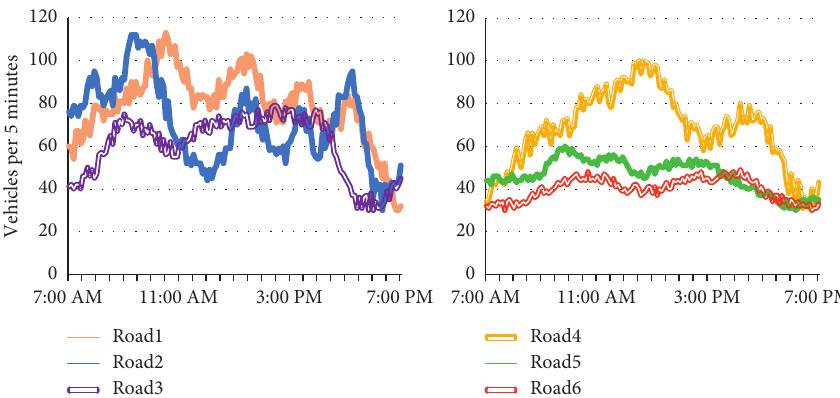
Figure 8: Six time series of traffic volume data.